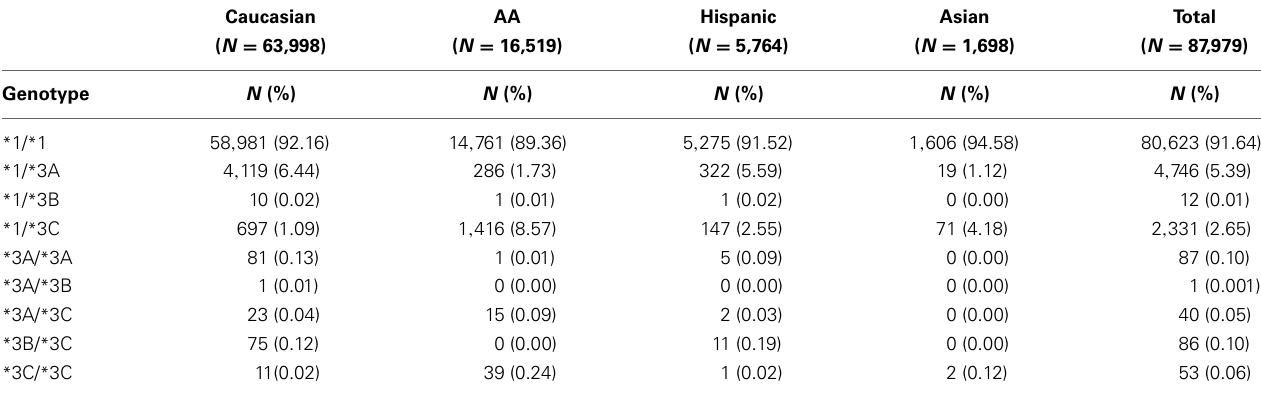
Table 4 | TPMT genotype-associated phenotypic frequencies across the different ethnic groups. Caucasian